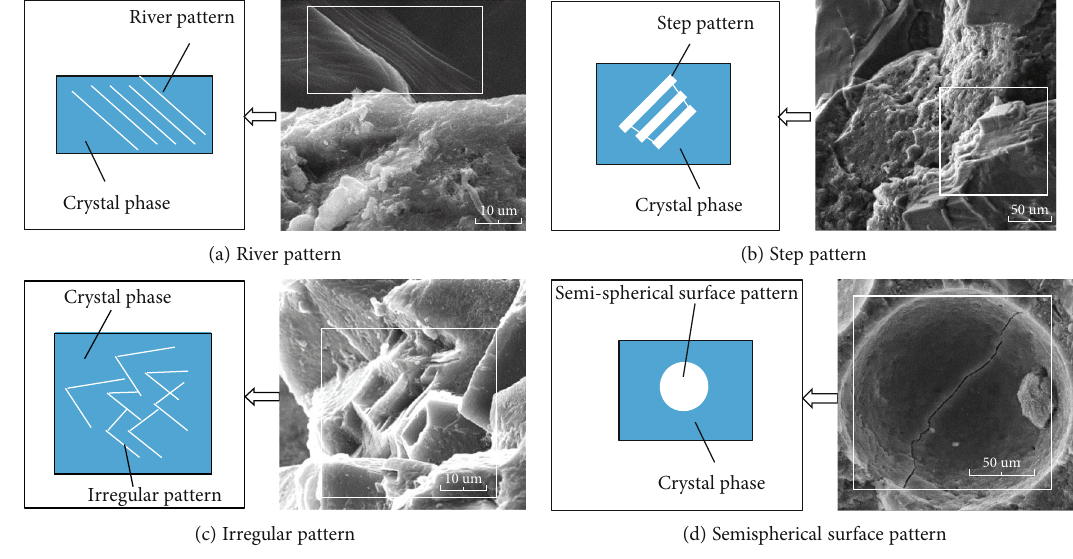
Figure 7: Brittle fracture morphology.